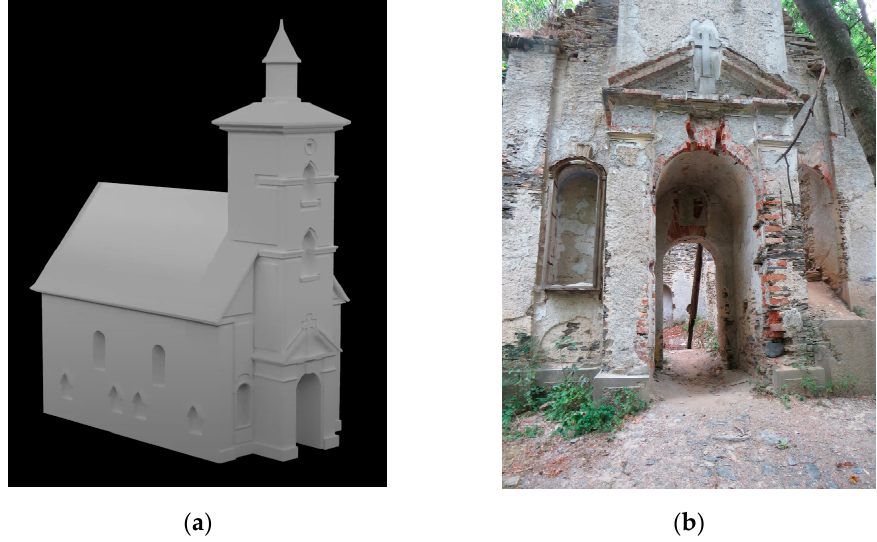
Figure 3. Chapel St. Anne, Hutov (Hutdörfel), district Bruntál: ( a ) 3D model based on historical